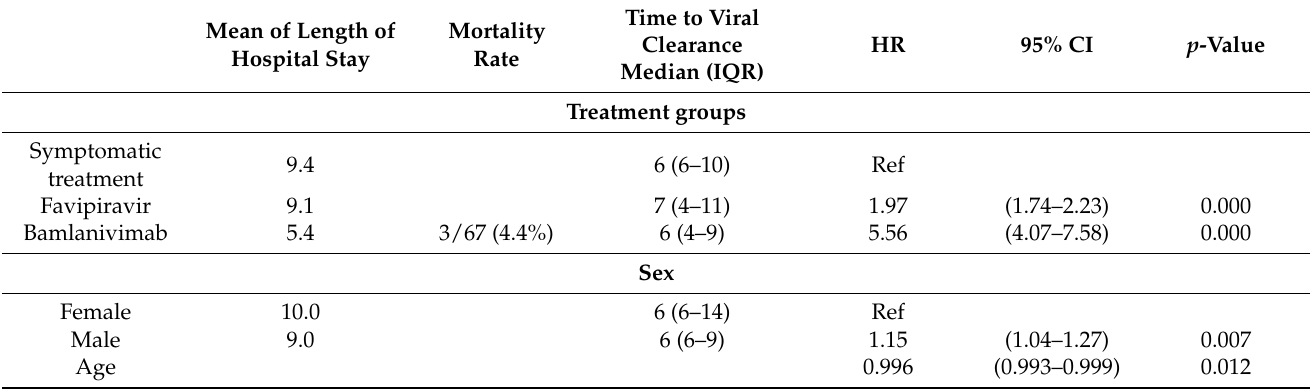
Table 1. Analysis of the time to viral clearance with adjustments for age and gender.